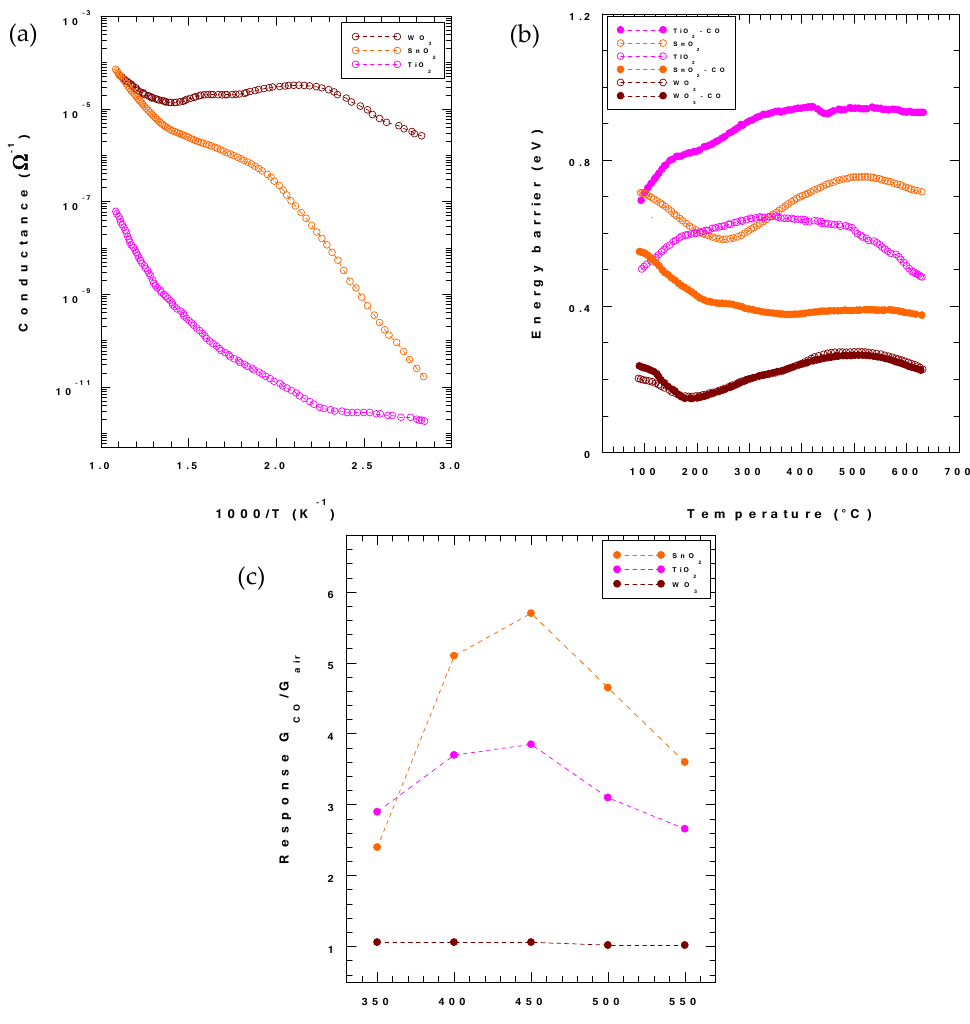
Figure 1. Conductance vs. temperature in dry air ( a ), comparison between the energy barrier dependence on temperature in dry air and in a mixture of dry air and CO (100 ppm) ( b ), responses to 50 ppm of CO reported as G CO /G air obtained at different temperatures ( c ) for the pure oxides. By observing the corresponding curves of the energy barrier as a function of temperature, and by comparing those in dry air with those in the mixture of dry air and carbon monoxide, some observations can be made: (i) SnO 2 and WO 3 exhibit a similar trend vs. temperature, but with lower values in the case of WO 3 ; (ii) comparing the energy barrier values in dry air or in the mixture of dry air and CO, such values are very different in SnO 2 for which the barrier decreases after the surface chemical reaction with carbon monoxide (due to the transfer of electrons in the conduction band), while in WO 3 such mechanism is almost absent; (iii) the case of TiO 2 appears different for two reasons. On one